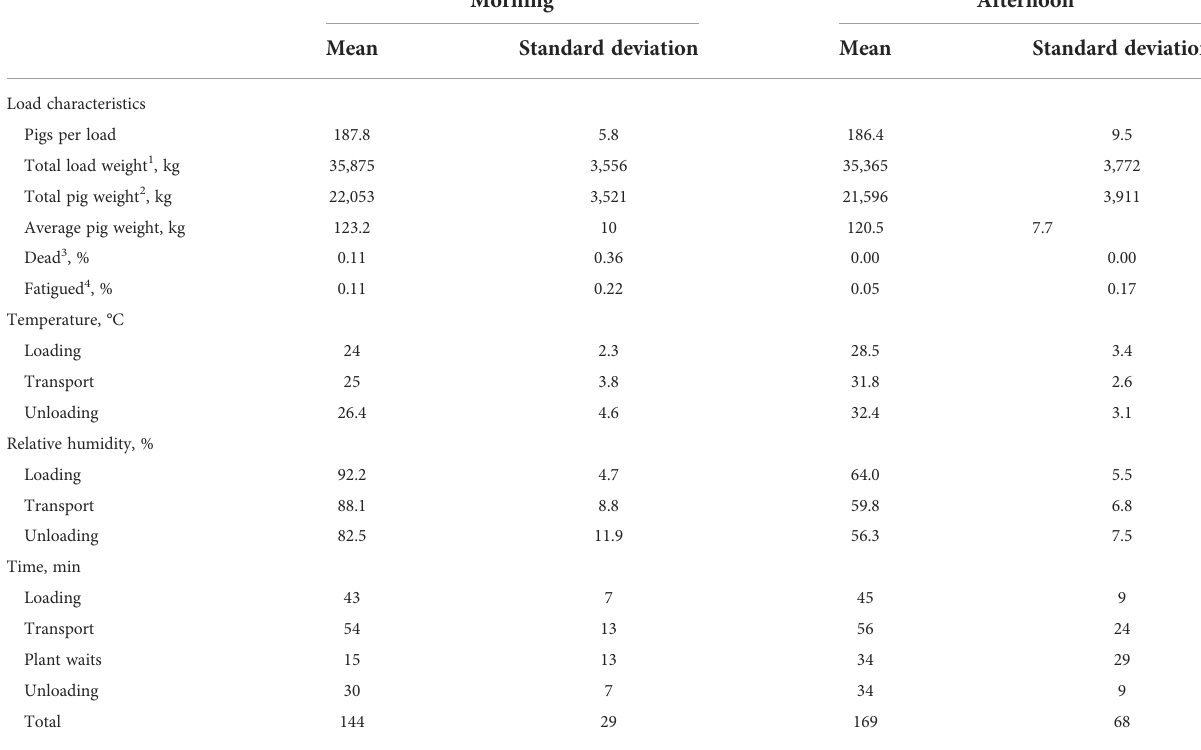
TABLE 1 Commercial pig transport characteristic means and standard deviations during loading, transport, and